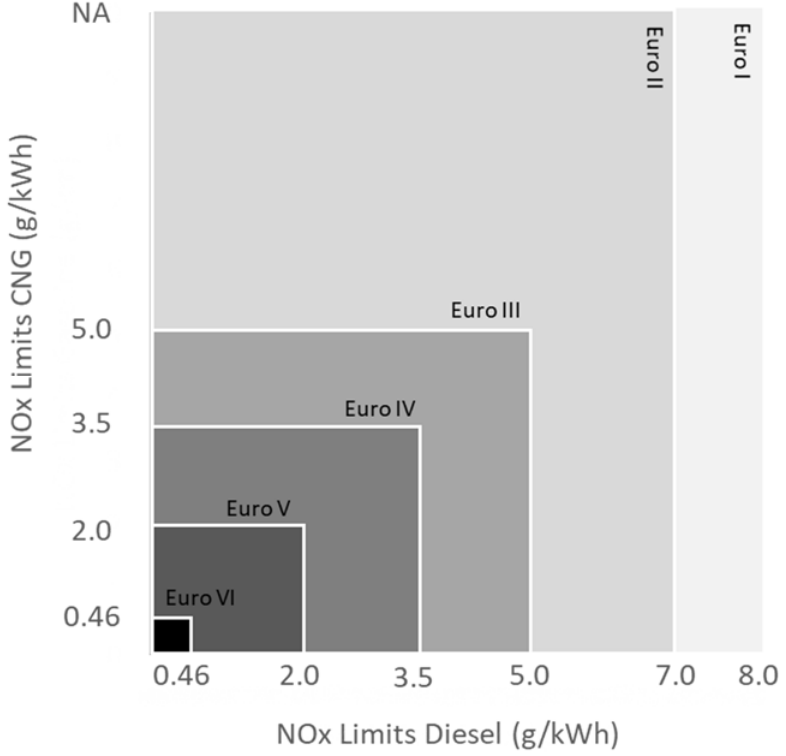
Figure 3. Evolution of NOx emissions limits enforced by EU regulation for CNG and Diesel heavy-duty vehicles (HDVs).